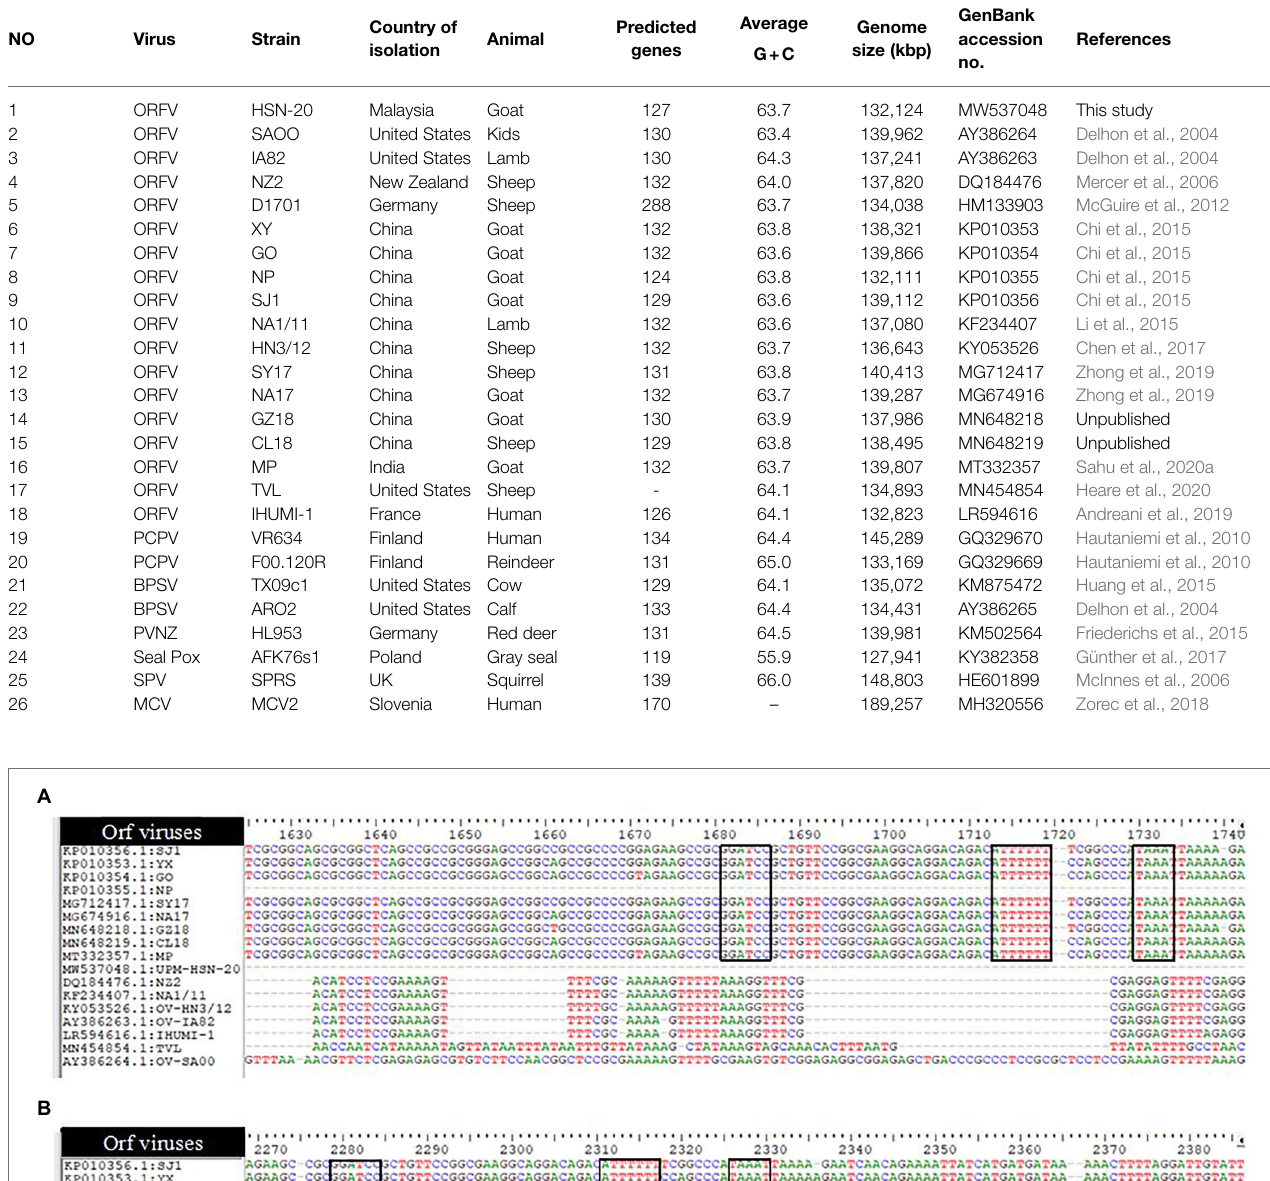
TABLE 1 | List of reference parapoxviruses used in this study.